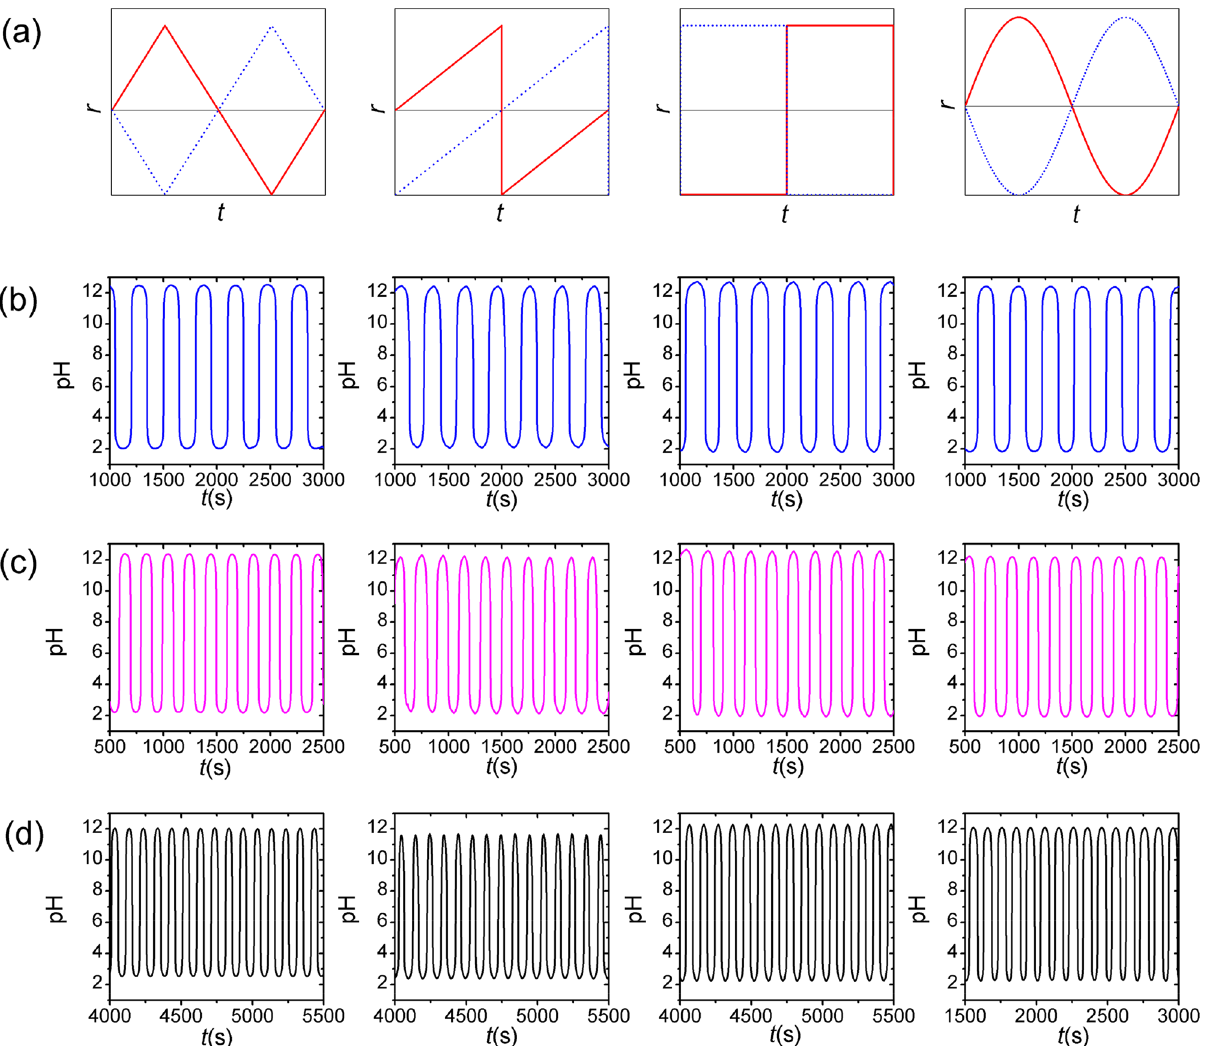
Figure 1. Non-autonomous pH oscillations in the acid–base neutralization reaction by using various time- dependent inflow rate functions (waveforms) of the reagents, acid and alkaline solutions, with the phase difference of π ( a ). The time periods of the various inflow rate functions (triangular, sawtooth, square and sinusoidal) were identical, T acid = T base = 300 s ( b ), T acid = T base = 200 s ( c ), and T acid = T base = 100 s ( d ). The concentrations of the acid and alkaline solutions in the input feed were 0.1 M ( c